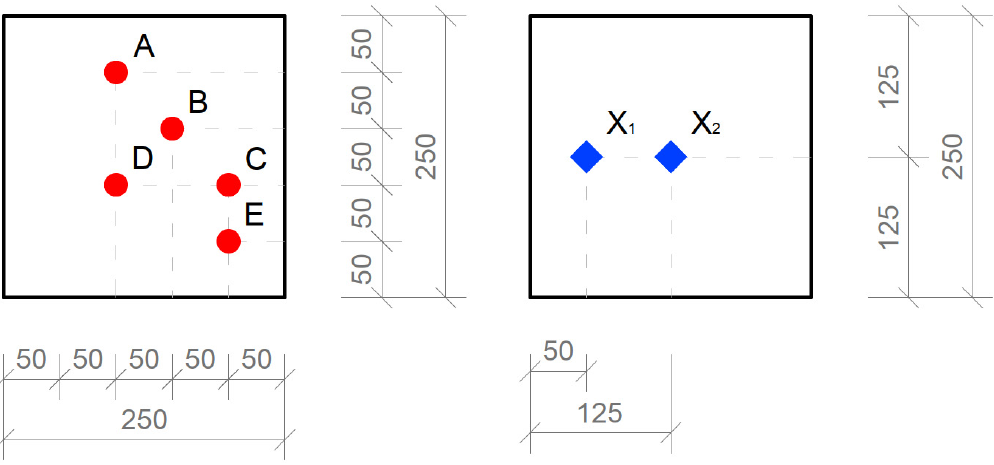
Figure 26. Drawing of measurement points of the horizontal plane of the model. Table 6. Illumination E (lx) and daylight factor D (%).